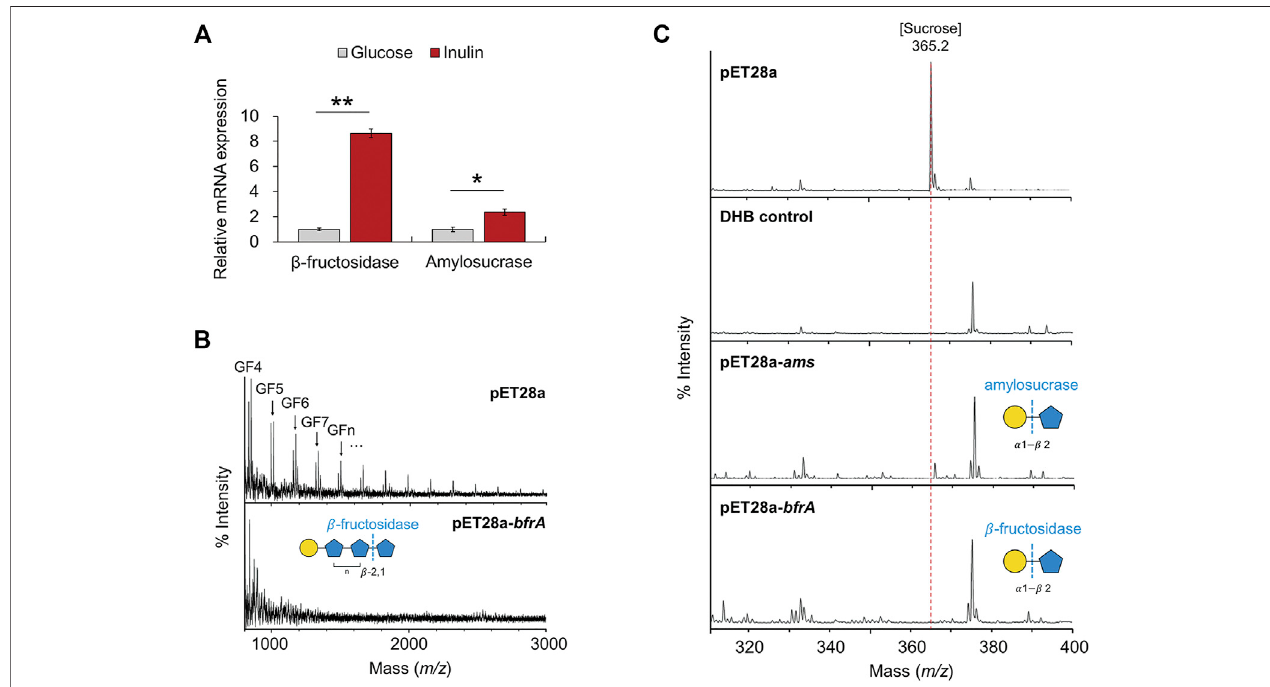
FIGURE 4 | Mass spectrometry analysis of cell lysates. (A) mRNA expression of glycoside hydrolases ( β -fructosidase, amylosucrase). The error bars indicate the standarddeviationoftriplicatesamples.* p < 0.05,** p < 0.01. (B) MALDI-TOF-MSspectraofinulindegradedbycelllysatesofpET28a- bfrA .PeaksarelabeledbyDP.G, glucose; F, fructose. All molecular ions are [M + Na] + . (C) MALDI-TOF-MS spectra of sucrose degraded by cell lysates of pET28a- ams , and pET28a- bfrA . All molecular ions are [M + Na] +